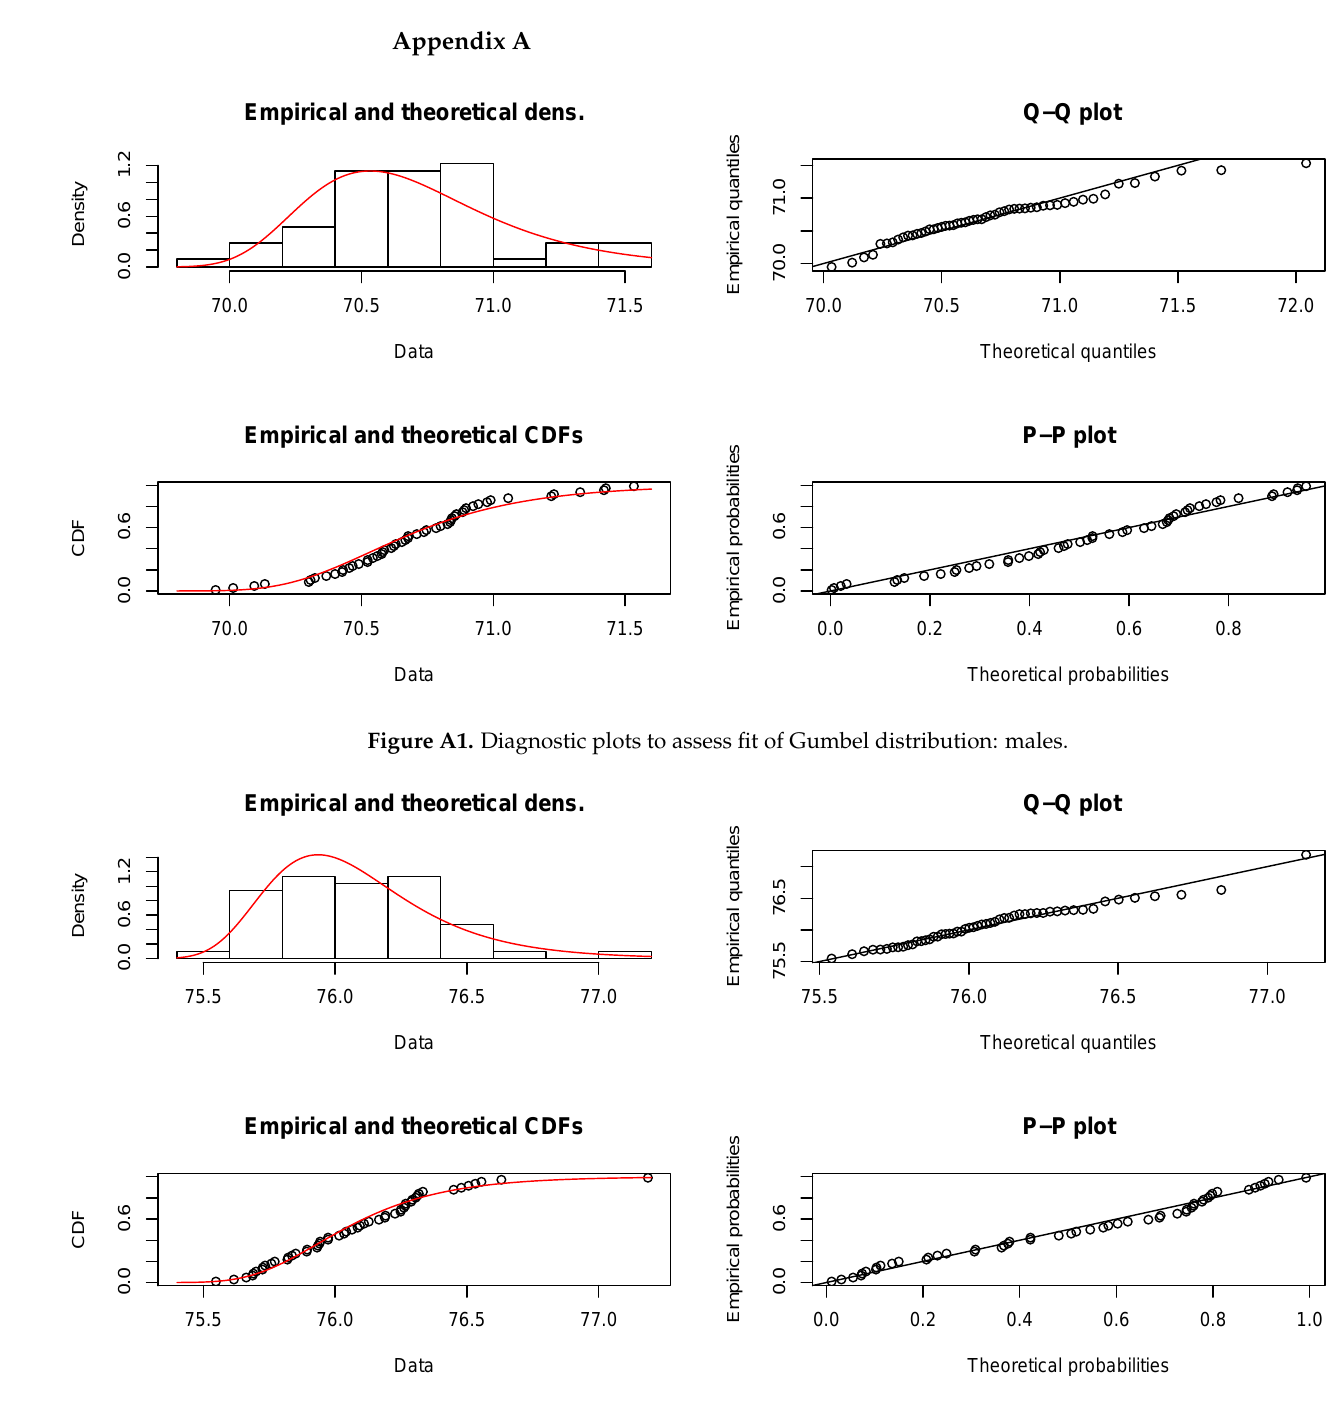
Figure A2. Diagnostic plots to assess fit of Gumbel distribution: